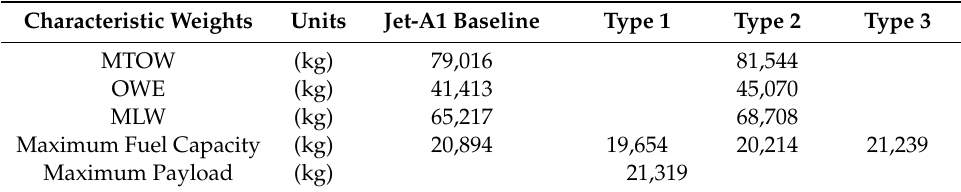
Table 8. Sized aircraft weight breakdown.